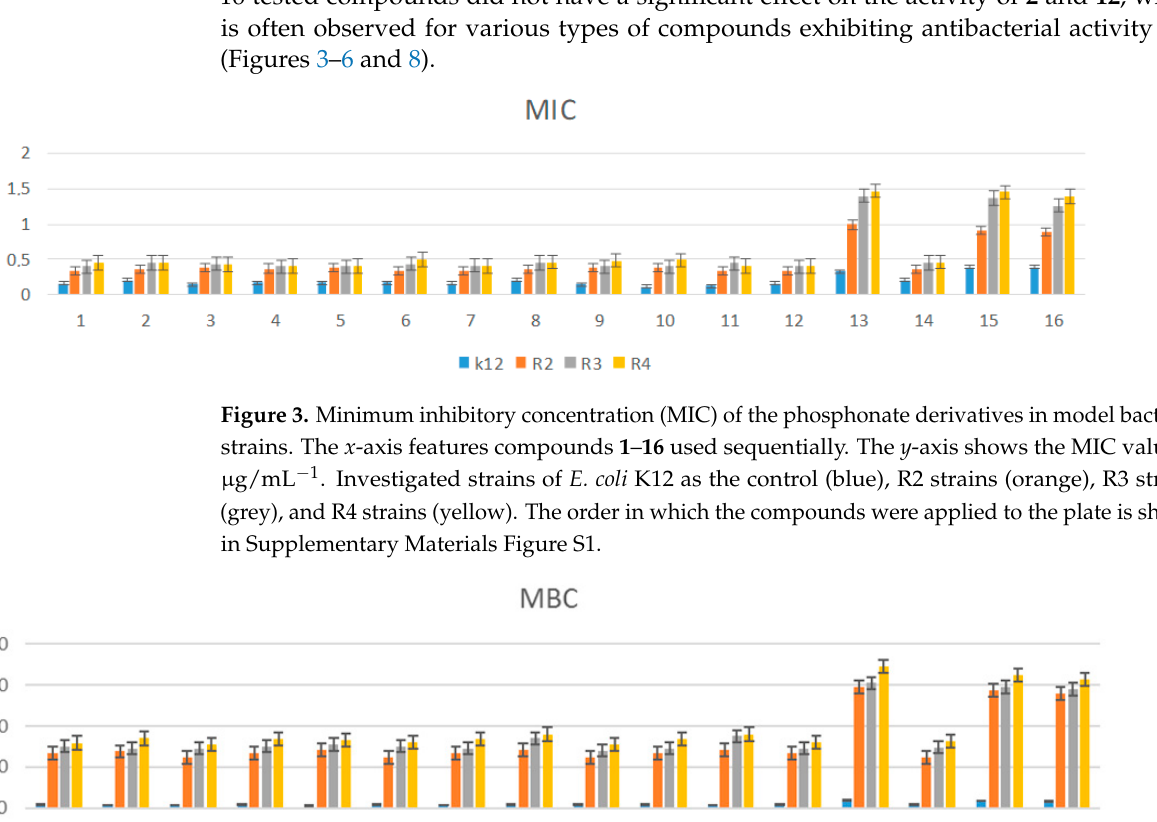
Figure 5. The ratio of MBC/MIC of the phosphonate derivatives. The x -axis features compounds 1 – 16 used sequentially. The y -axis shows the MIC value in µg/mL − 1 . Investigated strains of E. coli K12 as control (blue), R2 strains (orange), R3 strains (grey), and R4 strains (yellow). The order in which the compounds were applied to the plate is shown in Supplementary Materials Figure S1. Table 2. Statistical analysis of all analyzed compounds by MIC, MBC, and MBC/MIC; <0.05 *, <0.01 **, <0.001 ***. No. of Samples